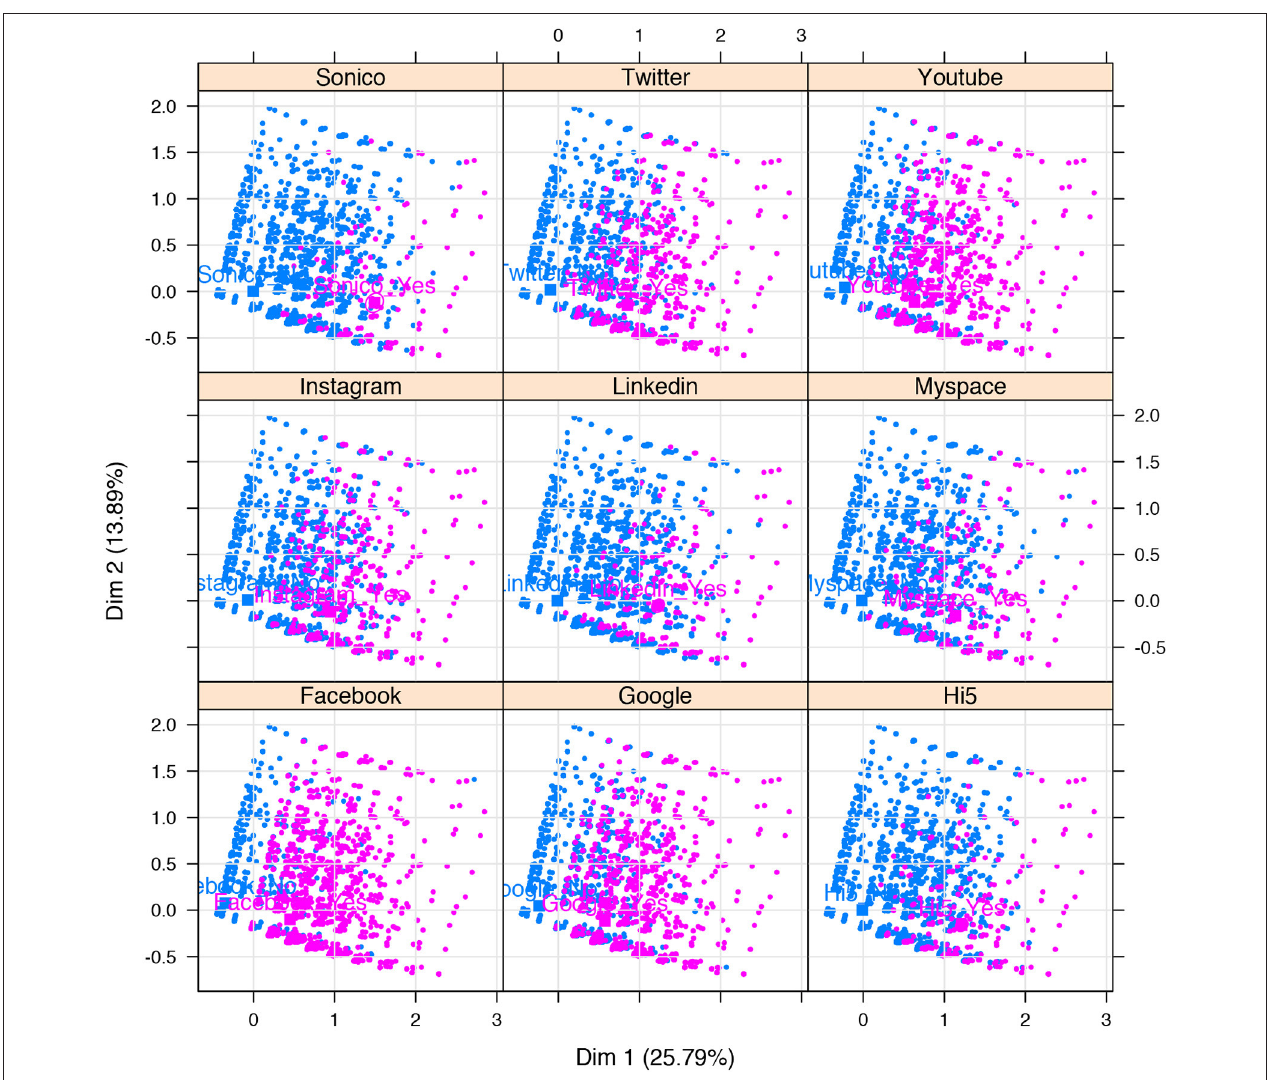
FIGURE 5 | Individuals by social networking site use ( n = 19,050 individuals). The cloud for each site shows individuals who used it in magenta and those who did not in